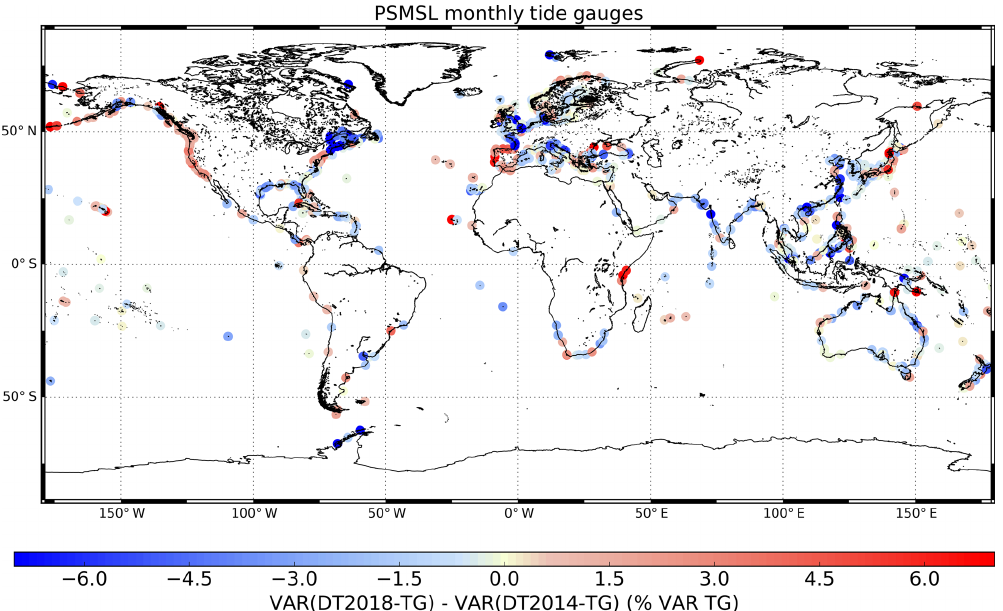
Figure 7. Difference of the variance between gridded SLA products and TG successively using the DT2018 and DT2014 gridded prod- ucts. We used mean monthly TG measurements from the PSMSL network. Negative values represent reduced differences between DT2018 altimetry gridded SLA and TG. The statistic is expressed as a percentage of the RMS of TG